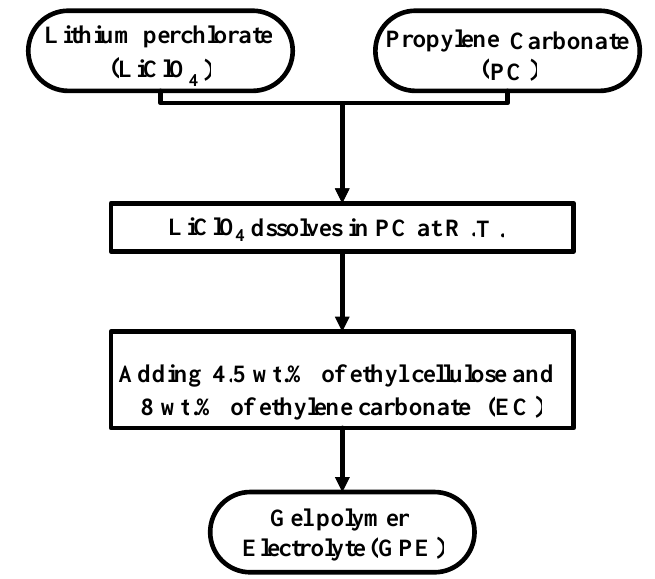
Figure 1. The fabrication process of the gel polymer electrolyte (GPE).